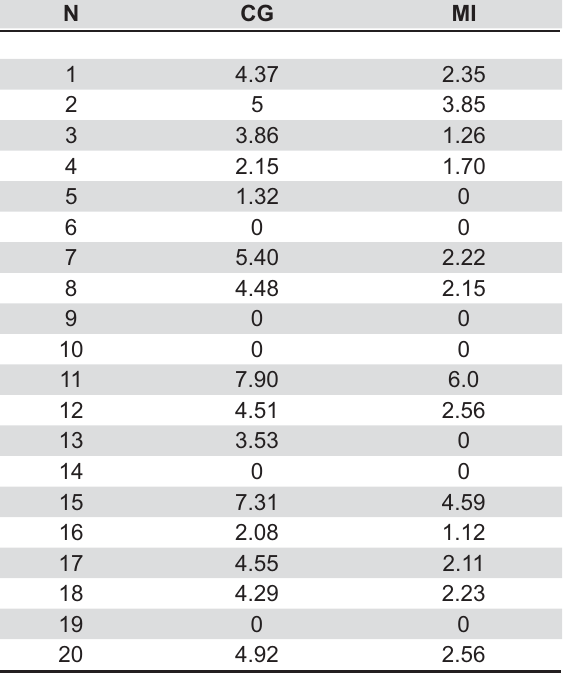
Table 2- Total of cfu (Log 10) of the yeasts after the use of the brushing and water (Control group) and after the use of the Medical Interporous TM Dentures tablet